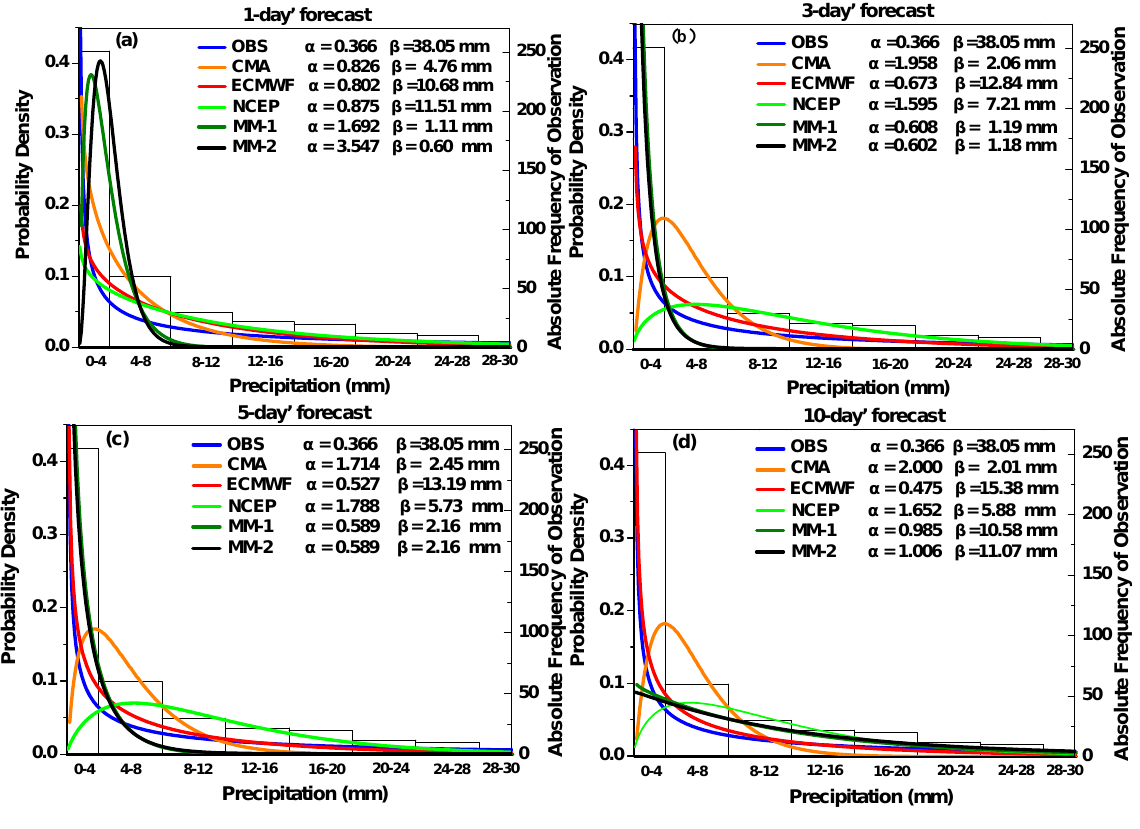
Fig. 2. Gamma distribution density function of daily precipitation of 5 EPSs, CMA (orange line), ECMWF (red line), NCEP (green line), MM-1 (olive line) and MM-2 (black line) with a lead time of 1-day (a) , 3-day (b) , 5-day (c) , and 10-day (d) . The Gamma distribution density function of observation is blue line. The histogram is observation sample frequencies of the daily